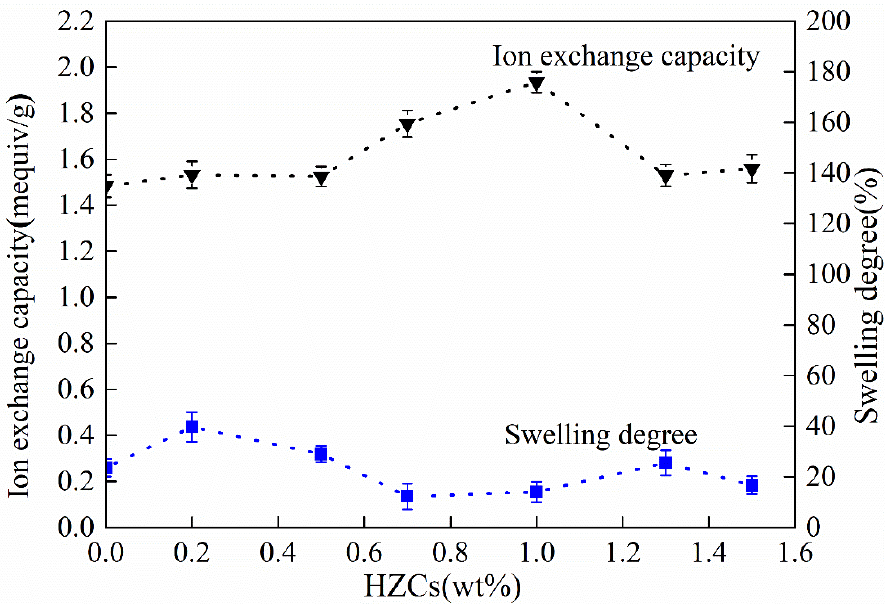
Figure 8. Effect of HZCs loading on IEC and SD of the nanocomposite membrane.